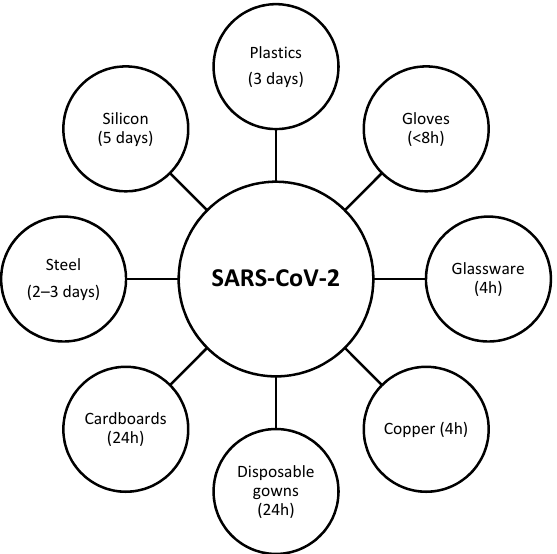
Figure 2. Persistence of SARS-CoV-2 coronavirus on different wastes [7]. Coronavirus persistence reaches the lowest level on glassware, copper (4 h) [7] and gloves (<8 h) [7], while it is the highest on silicon (5 days) [7], plastics (3 days) [7] and steel